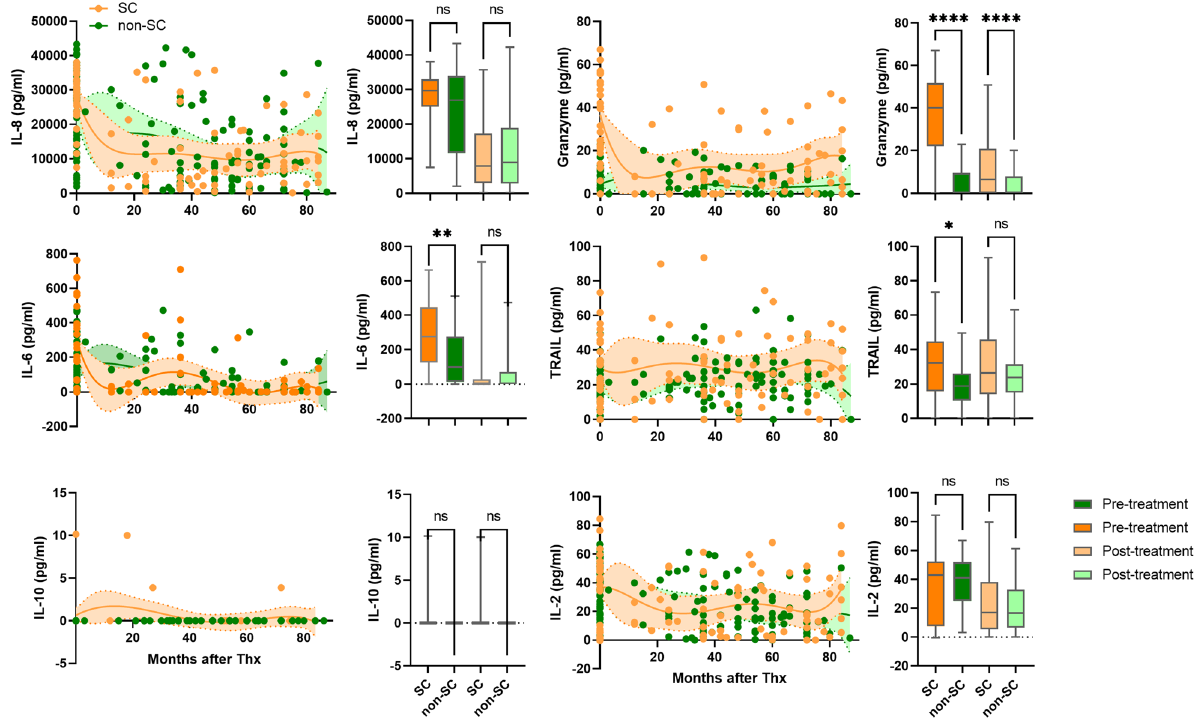
Figure 7. Levels of cytokine levels in SC patients and non-SC patients. Circulating IL-8, IL-6, IL-10, granzyme, TRAIL, and IL-2 in SC patients (orange dots) and non-SC patients (green dots). Shaded areas indicate 95% confidence intervals around the regression lines. Bar graphs represent concentration of each cytokine in in pre- treatment (dark orange), post-treatment (light orange) of SC and pre-treatment (dark green), post-treatment (light green) of non-SC patients. *p ≤ 0.05, **p ≤ 0.01, ***p ≤ 0.001, ****p ≤